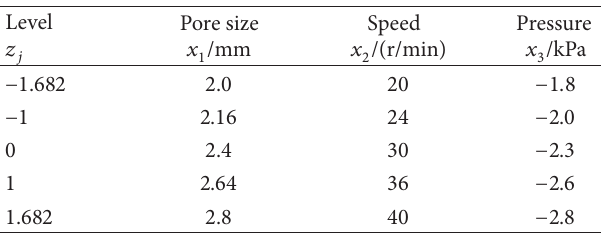
Table 2: Level code table of tests factors.